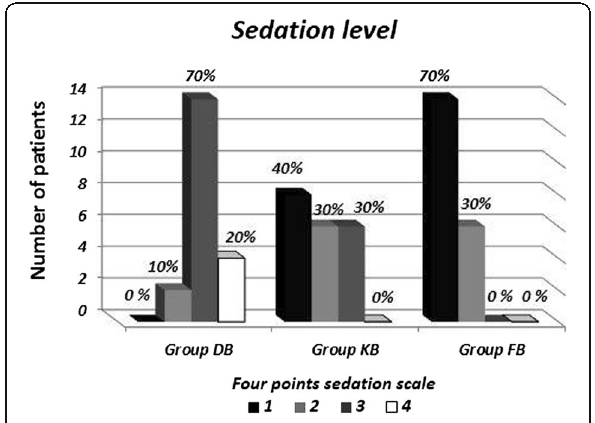
Fig. 2 Sedation level using 4-point